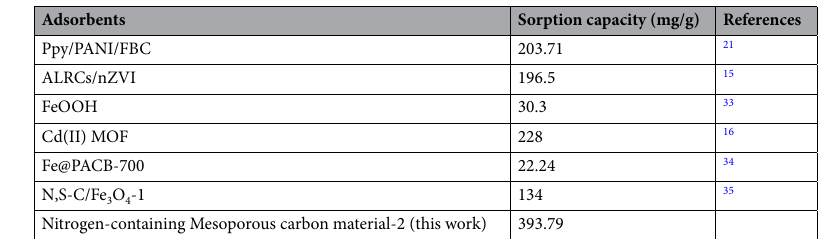
Table 2. Cr (VI) removal ability of NMC-2 composite compared with other